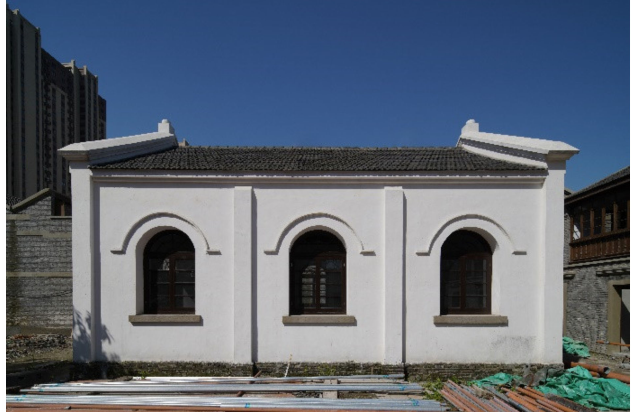
Figure 9. East facade of the church.